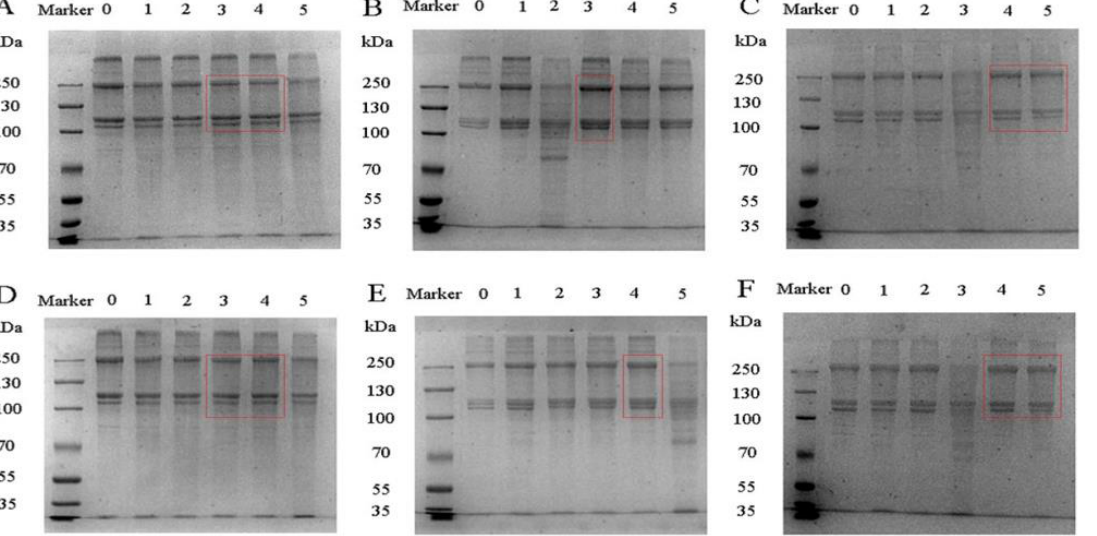
1650–1660 cm − 1 ( α helix), peak center 1660–1680 cm − 1 ( β turn) and peak center 1680–1700 cm −